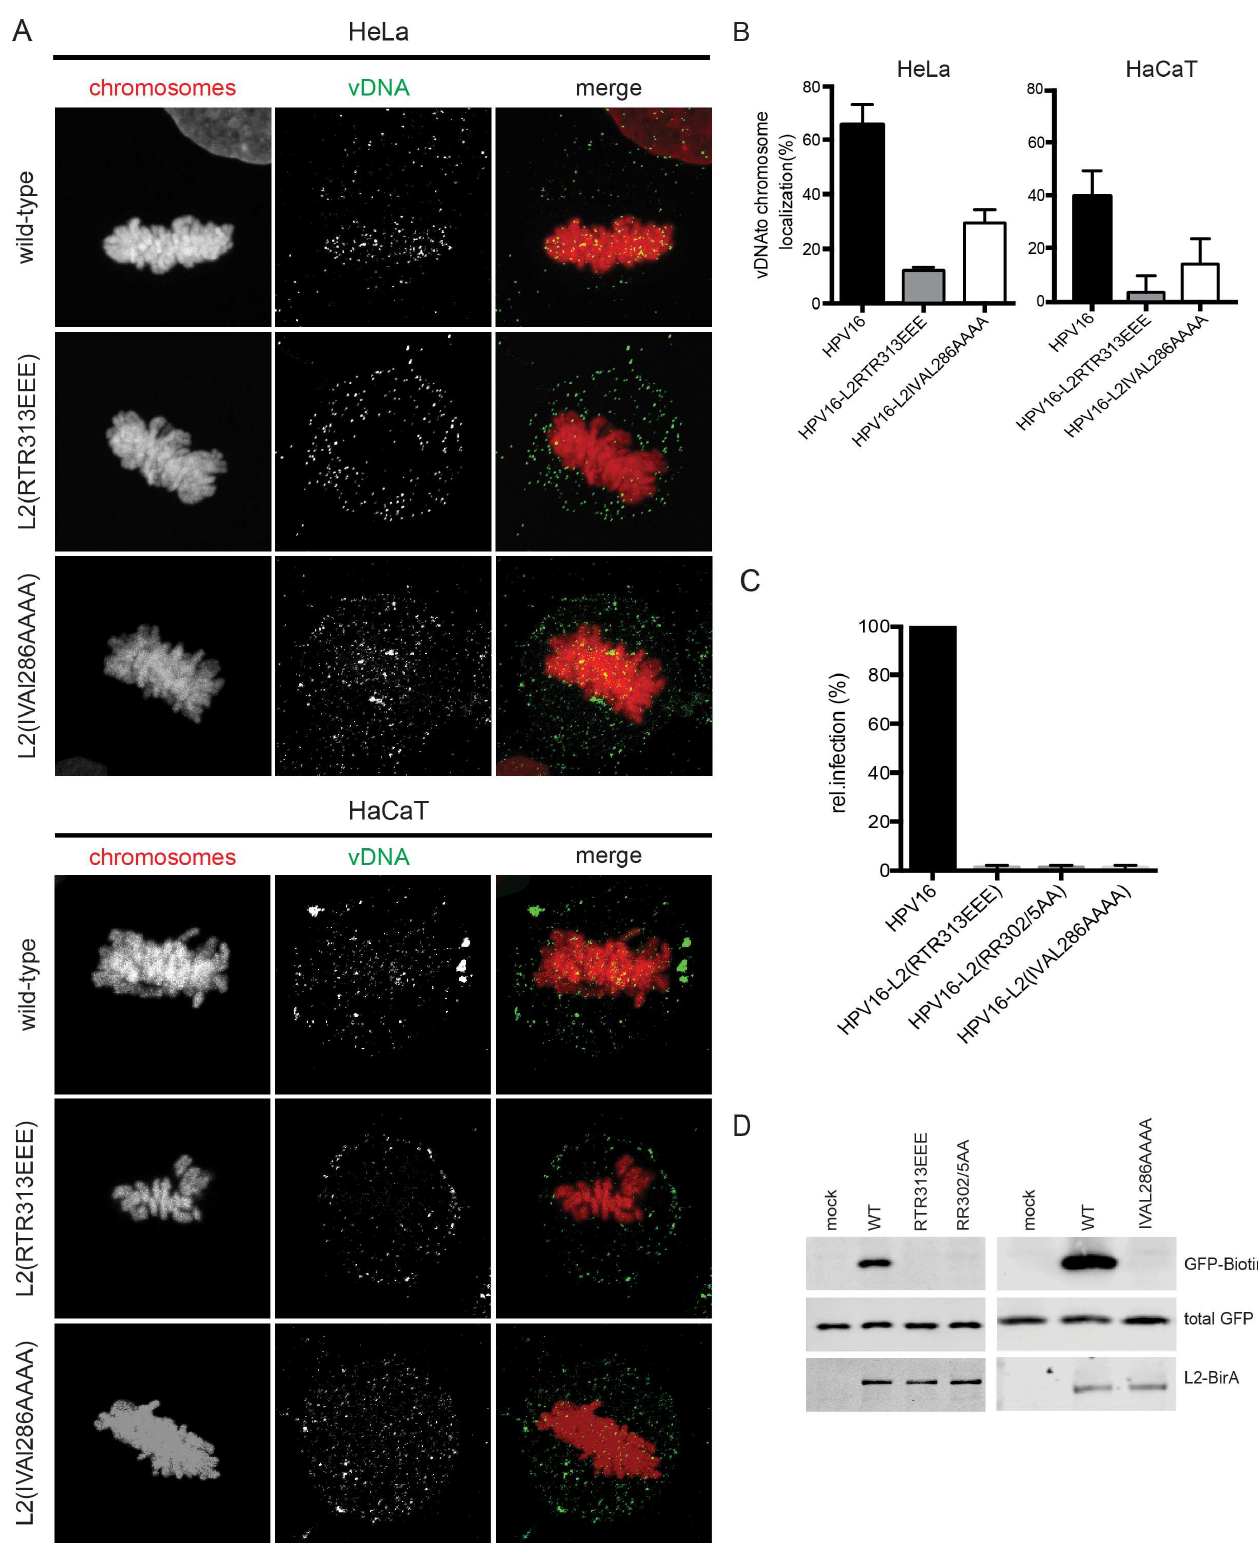
Fig 8. Mutant PsVs are defective in mitotic chromosome association of vDNA and membrane penetration of L2 C-terminus. (A), (B) Subcellular localization of incomingvDNA upon infection with EdU-HPV16, EdU-HPV16-L2(RTR313EEE)and EdU-HPV16-L2(IVAL286AAAA) in